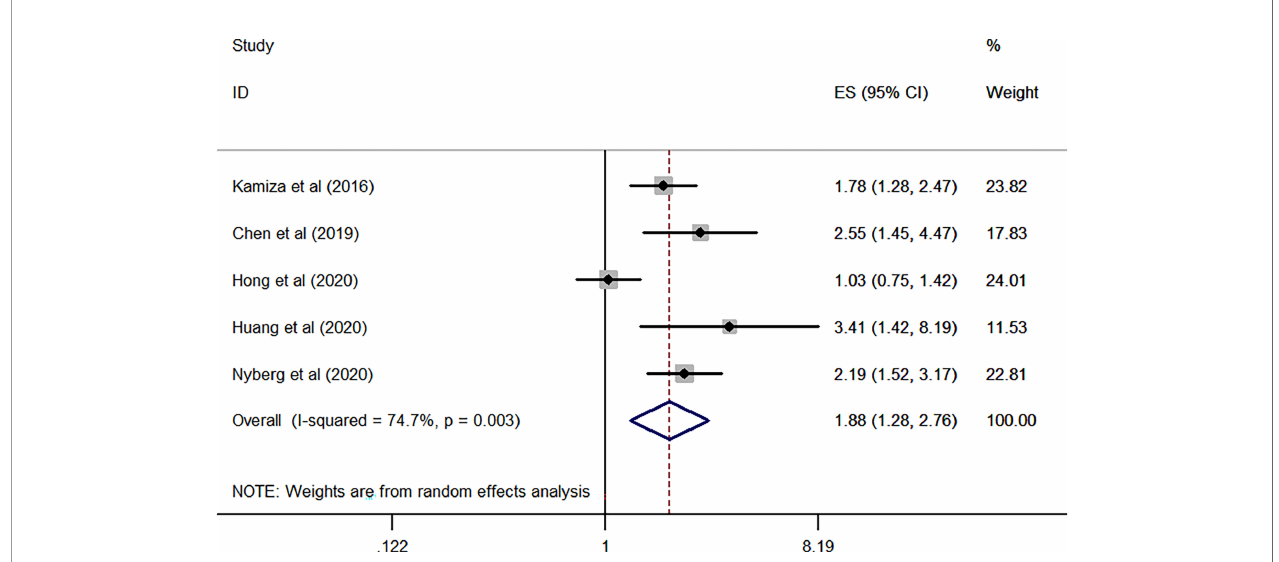
FIGURE 5 | Forest plots of the pooled analysis of the included studies on the association between HCV and risk of gastric